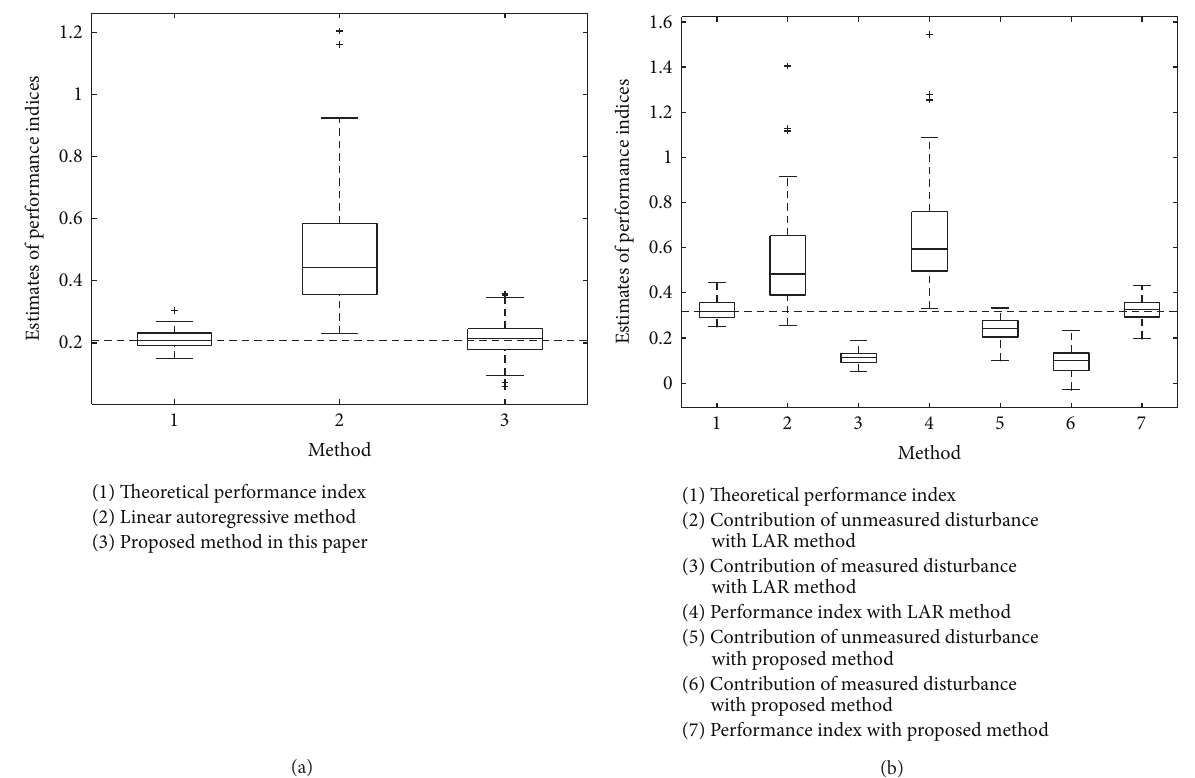
Figure 5: Box plots of the estimates of the minimum variance lower bound for the nonlinear feedforward and feedback control system. (a) 𝑏 = 3 , 𝑙 = 5 ; (b) 𝑏 = 5 , 𝑙 = 3 .